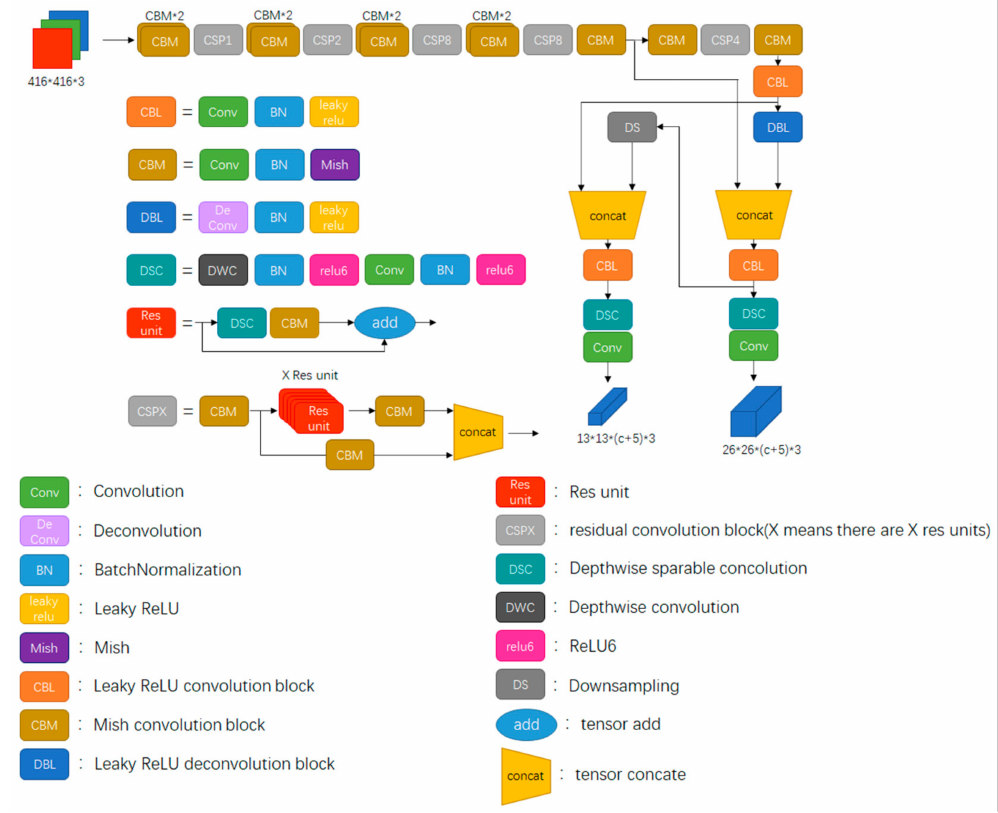
Figure 7. Structure of